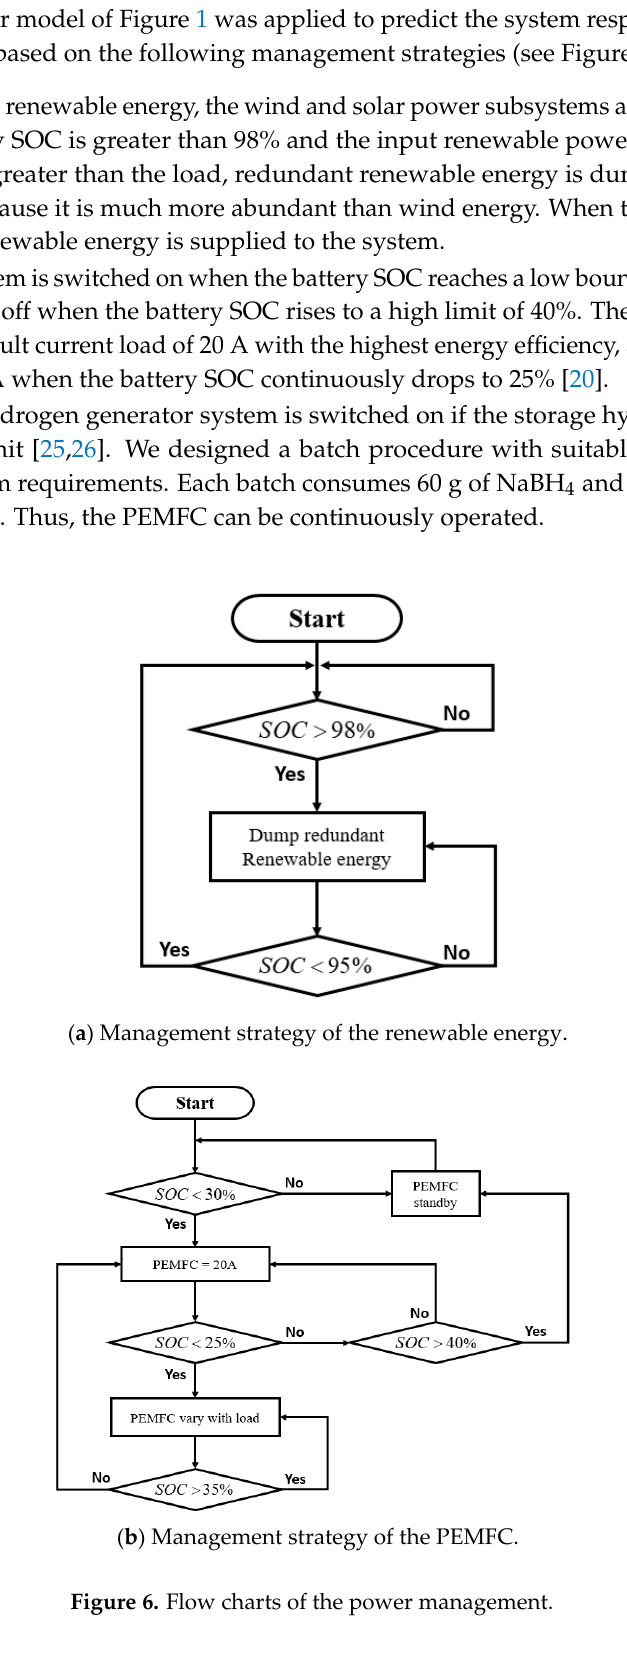
Figure 5. Experimental responses of the hydrogen electrolysis system.